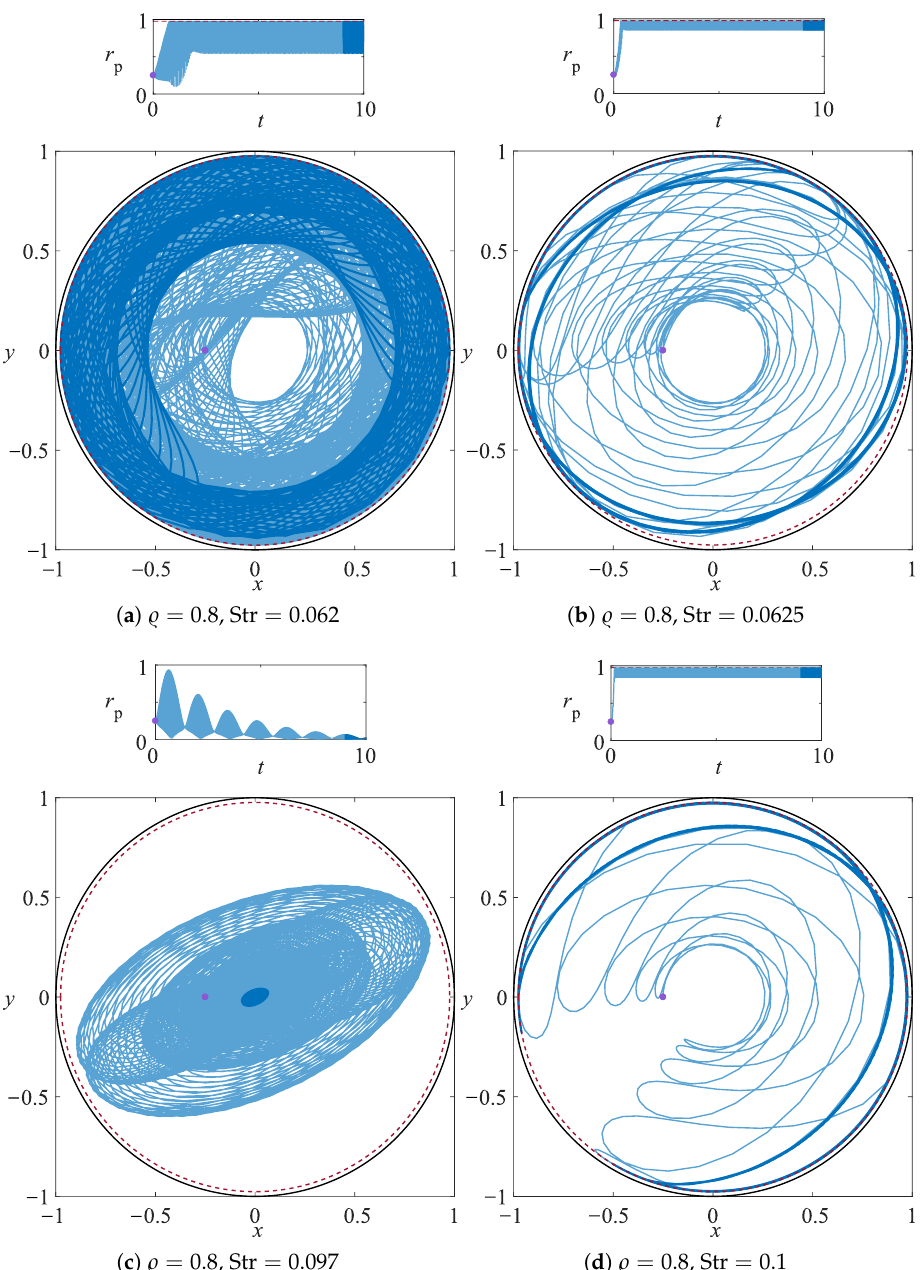
Figure 3. Radial coordinate r p of a particle trajectory for (cid:36) = 0.8, St = 1 and Str = 0.062, 0.0625, 0.097, and 0.1. The trajectories are integrated for t = 10 and they are denoted by the light-blue line. The darkblue solid line shows the last 10% of the particle orbit and the purple dot its initial position. The red dashed line identifies the sliding surface of the PSI model, which surface is at distance ∆ = a from the driving